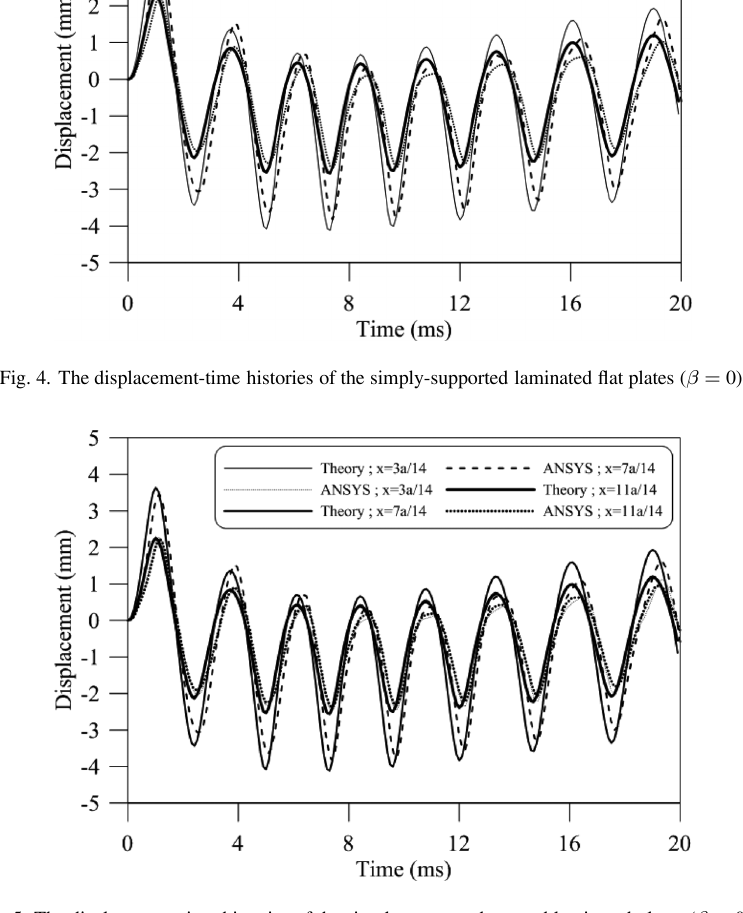
Fig. 5. The displacement-time histories of the simply-supported tapered laminated plates ( β =